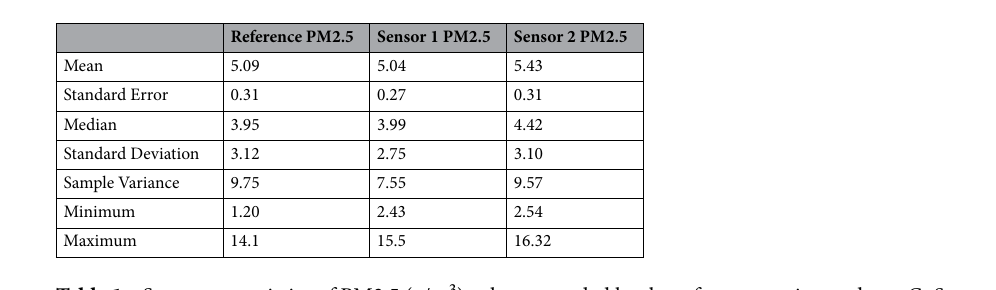
Table 1. Summary statistics of PM2.5 (g/ m 3 ) values recorded by the reference station and two CoSense